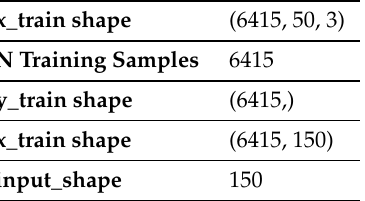
Table 3. Input data from the network.